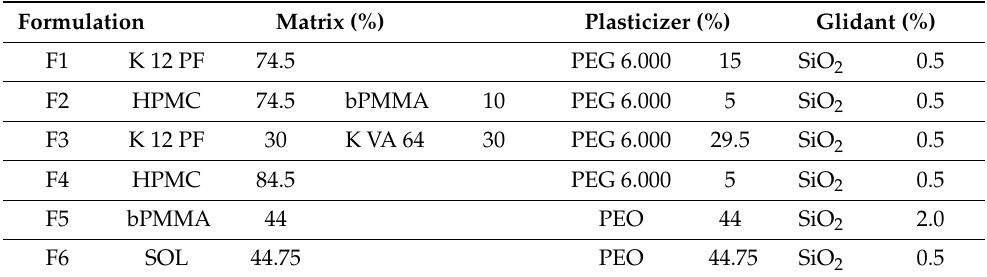
Table 1. Composition of HME formulations for screening experiments ( w / w